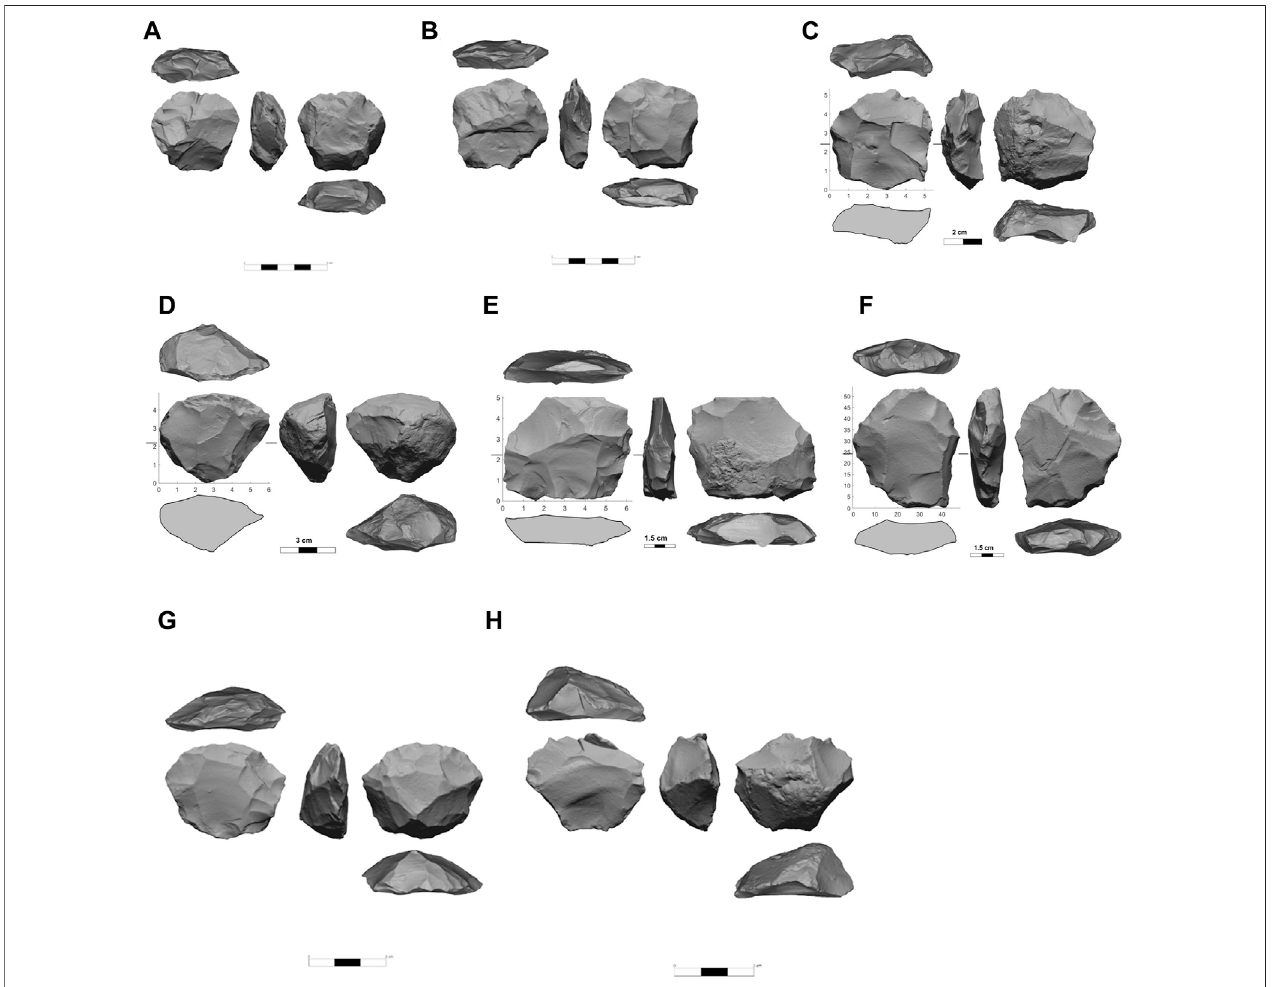
FIGURE 3 | Proto-Levallois centripetal (A – F) and preferential (G – H) cores from Jaljulia. Note the scars on the production surfaces indicating débordant removals (C,E,F,H) . The striking platform is shown in the left part of each fi gure.